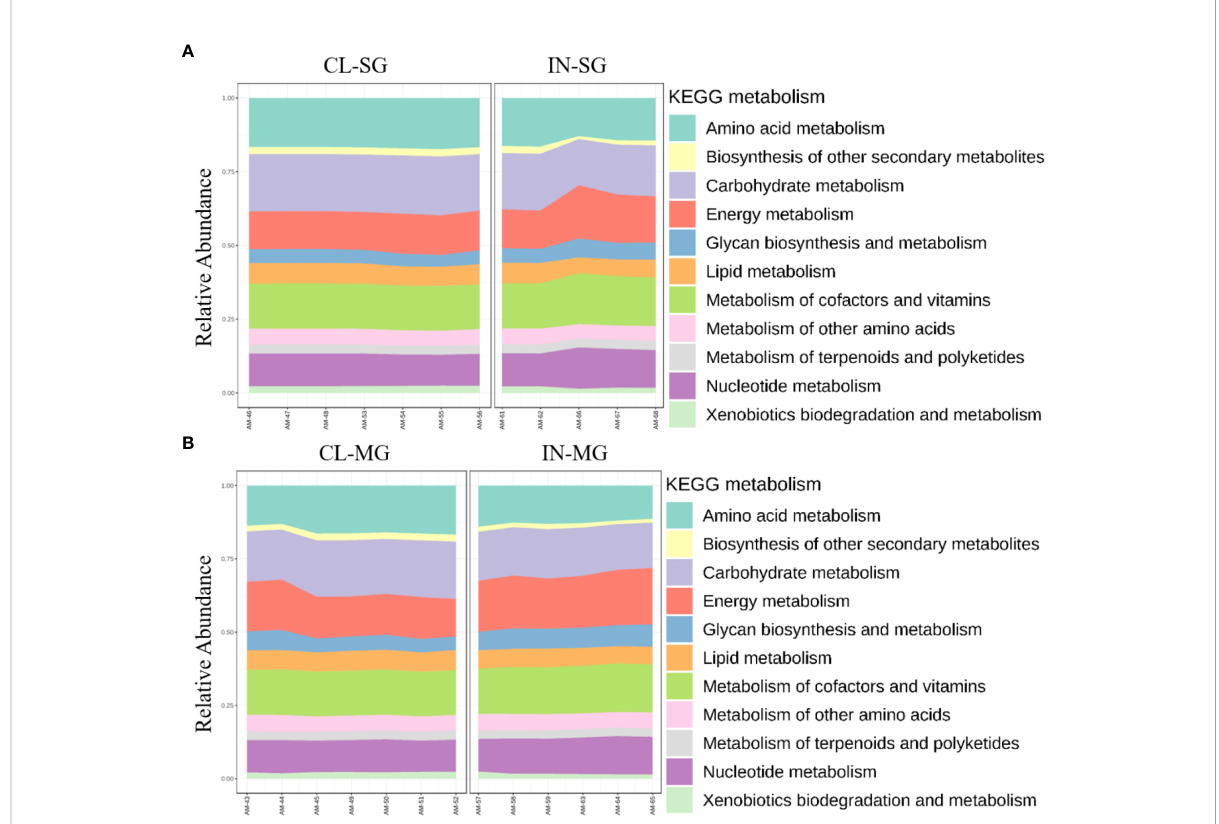
FIGURE 9 Histogram indicating the functional differences between the uninfected and R. parkeri-infected Am. maculatum microbiota in (A) salivary gland and (B) midgut tissues. KEGG metabolic categories were obtained from 16S rRNA gene sequences using the PICRUSt2